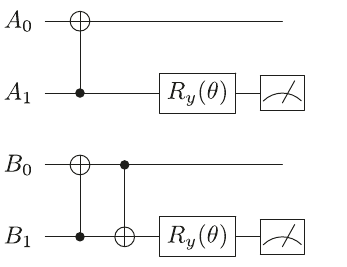
Fig. 2 Circuit of a distillation protocol learned by LOCCNet for S states. This simpli fi ed circuit represents local operations in a distillation protocol learned by LOCCNet for two copies of an S and ρ A . The rotation angles of both R y gates are state, ρ A 0 B 0 1 B 1 θ ¼ arccos ð 1 (cid:2) p Þ þ π , which depend on the parameter p of the S states to be distilled.